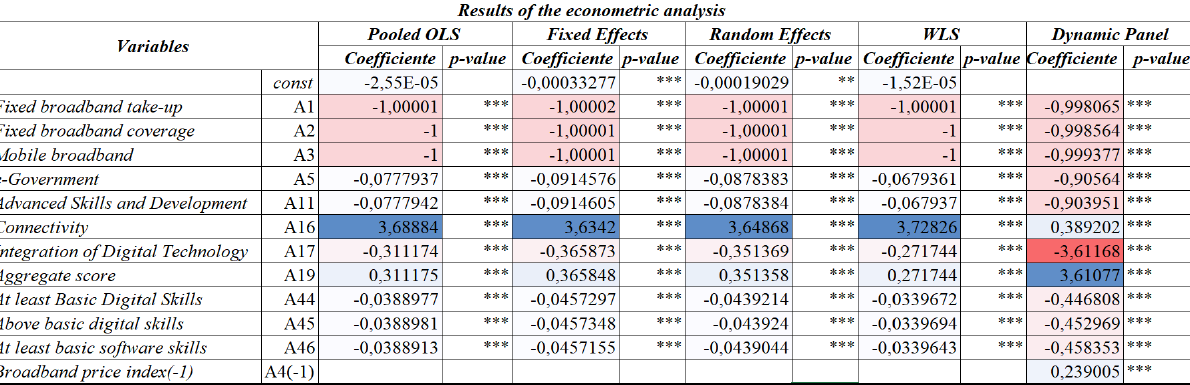
Figure 1. Results of the econometric